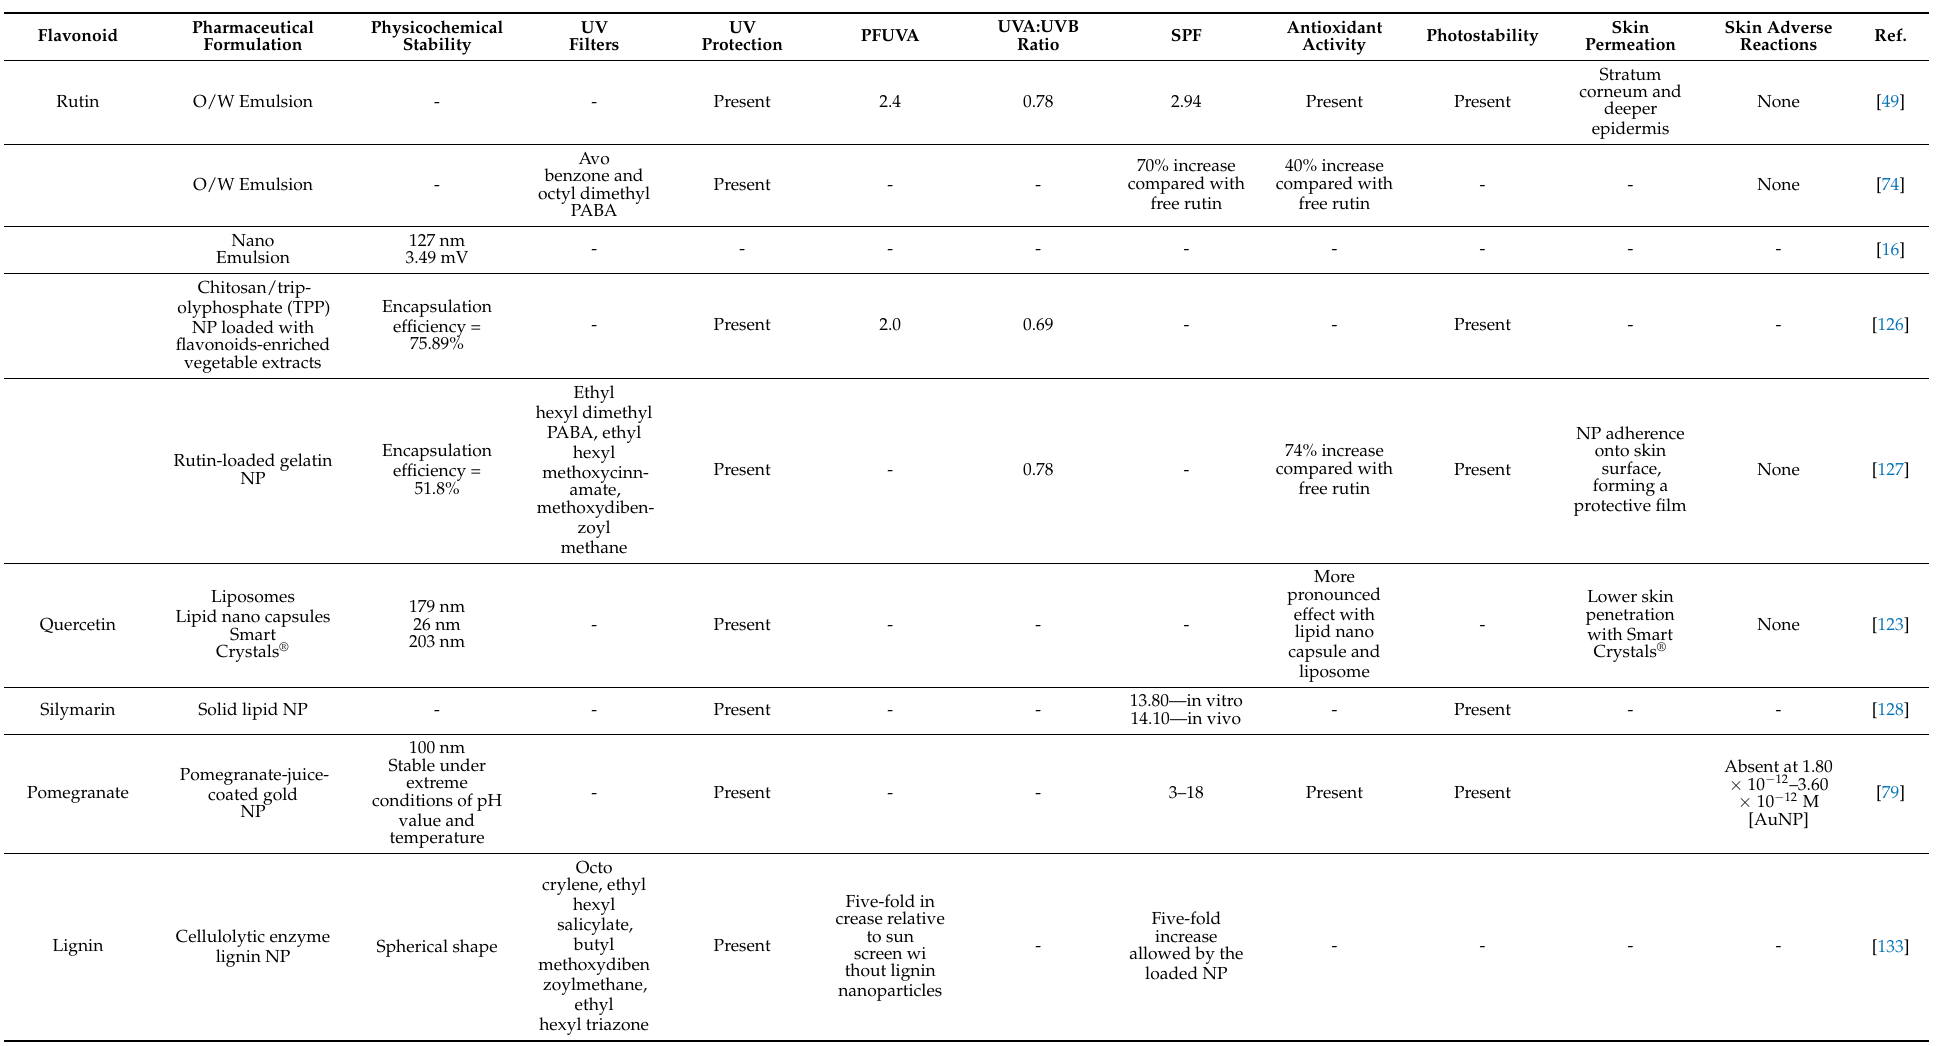
Table 2. Main findings in studies performed about flavonoid nano-formulated sunscreens with evident UVA